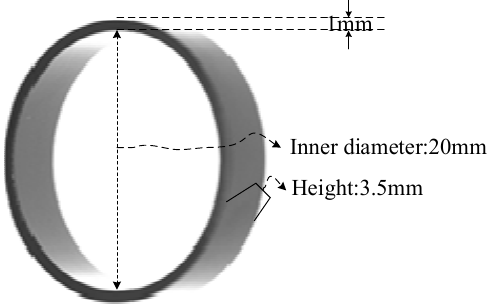
Figure 1. Physical image of the magnetic ring.